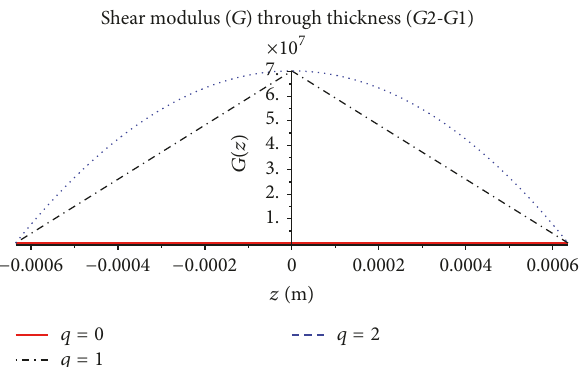
Figure 2: Graded shear modulus distribution through thickness in 𝐺1 - 𝐺2 core.